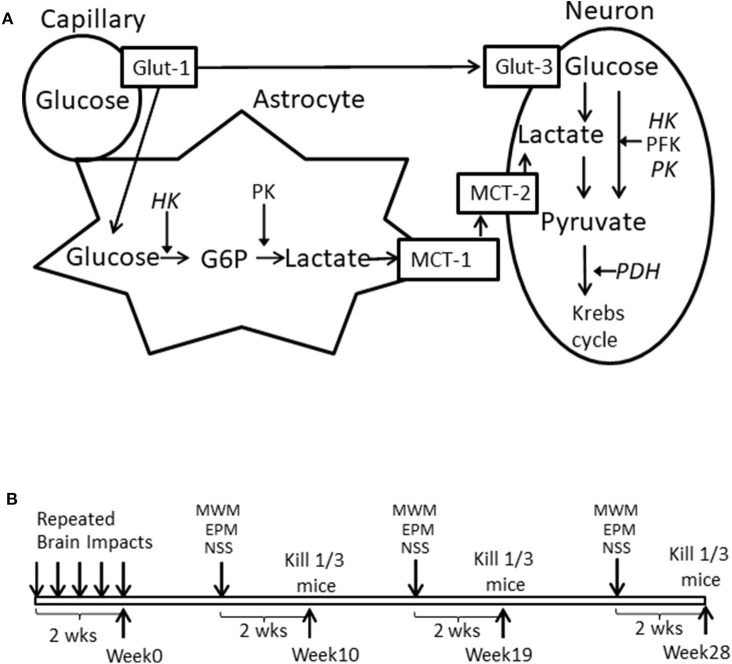
(A) Schematized brain glucose utilization among capillaries, astrocytes and neurons. HK, Hexokinase; PFK, phosphofructokinase; PK, pyruvate kinase. PDH, Pyruvate dehydrogenase; Glut-1, Capillary Glucose transporters 1; Glut-3, Neuronal glucose transport 3; MCT-1, Astrocyte monocaboxylate (lactate) transporters 1; MCT-2, neuronal monocaboxylate (lactate) transporters 2. (B) Illustration of experimental schedule.